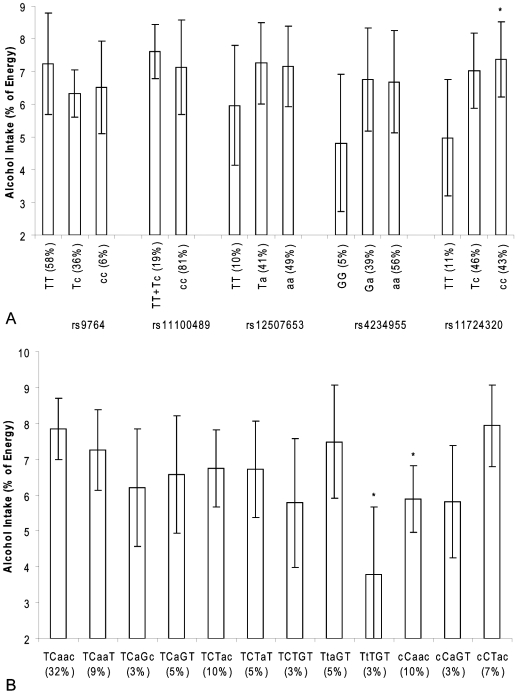

NPY1R/NPY5R variants and alcohol intake in the Hamlet population.
Figure 3a shows the association of SNPs in the NPY1R/NPY5R region with alcohol intake as percentage of total energy intake. The ancestral alleles are indicated as capital letters. *p<0.05, **p<0.01(compared with linear regression model), # P<0.01 for trend. Figure 3b shows the association of NPY1R/NPY5R haplotypes with alcohol intake as percentage of total energy intake. The haploblocks consist of the SNPs rs9764, rs11100489, rs12507653, rs4234955 and rs11724320 and the ancestral alleles are indicated as capital letters. *p<0.05 (compared with linear regression model).